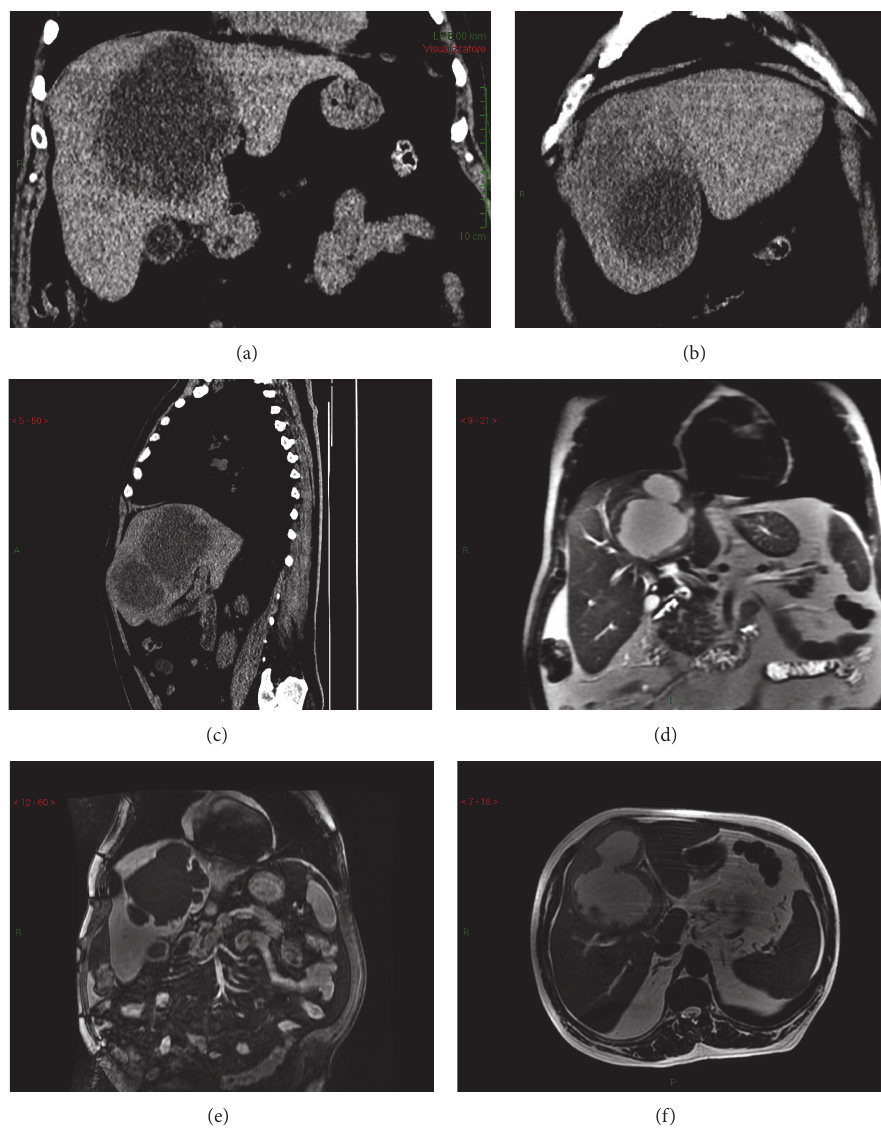
Figure 1: CT scan and MRI imaging of the liver lesions. (a) CT scan. Coronal plane. Evidence of the wider abscess as hypodense area with blurred edges. It occupies the IV-V-VIII hepatic segments and its size is approximately 12 × 10 × 10 cm. (b) CT scan. Sagittal plane. Evidence of both abscesses into the right hepatic lobe. (c) CT scan. Coronal plane. Evidence of the smaller abscess as hypodense area. It is located between the IV-V segments and its size is approximately 3 × 3 × 3cm. (d) T2-weighted MRI. Coronal plane. Evidence of the wider abscess which determines ab estrinseco compression on the hepatic hilum. Moderate dilation of bile ducts of the VIII segment is also visible. (e) T2-weighted MRI. Axial plane. Evidence of communication between the two abscesses. (f) T1-weighted MRI after contrast medium. Coronal plane. Evidence of the wider abscess surrounded by communicating satellite